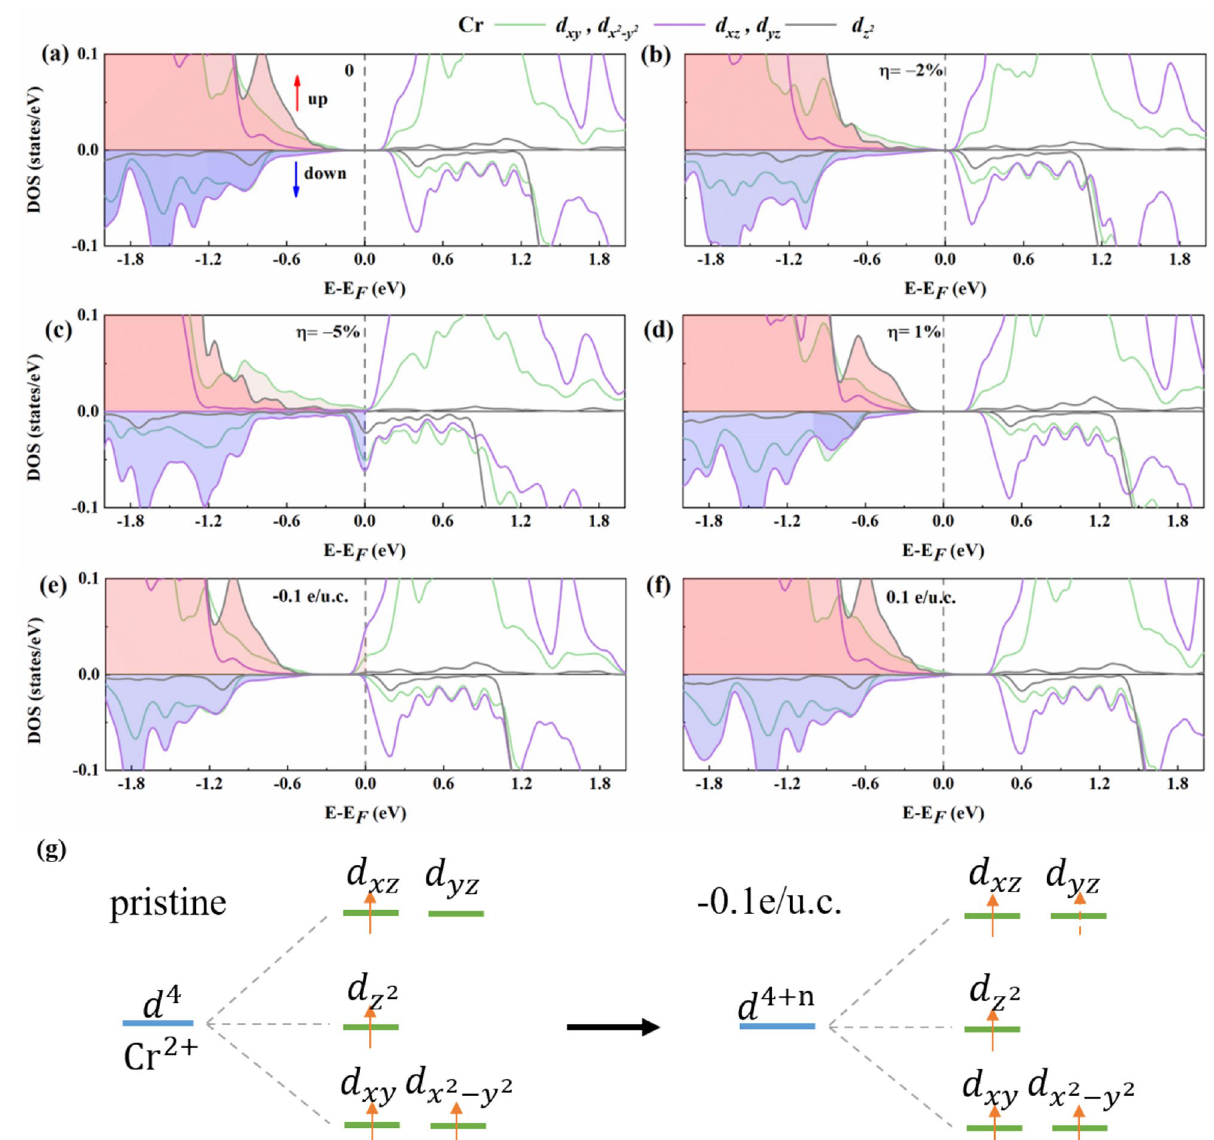
Figure 6. The spin-polarized projected density of states (PDOS) of Cr 2 Ge 2 Te 6 –Cr for bilayer Cr 2 Ge 2 Te 6 : ( a ) pristine, ( b ) compressive strain of 2%, ( c ) compressive strain of 5%, ( d ) tensile strain of 1%, ( e ) electron doping of 0.1 e/u.c, and ( f ) hole doping of 0.1 e/u.c. ( g ) The electronic configuration for pristine (left) and doping of − 0.1 e/u.c. (right). The red and blue arrows indicate spin-up and spin-down states, respectively. The occupied states are presented by colorfully filled